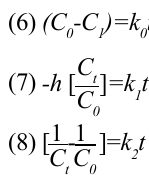
Figure 6. The reaction rate constants along with the corresponding correlation coefficients for Fe A: Zero; B: First; and C: Second-order kinetic curves.